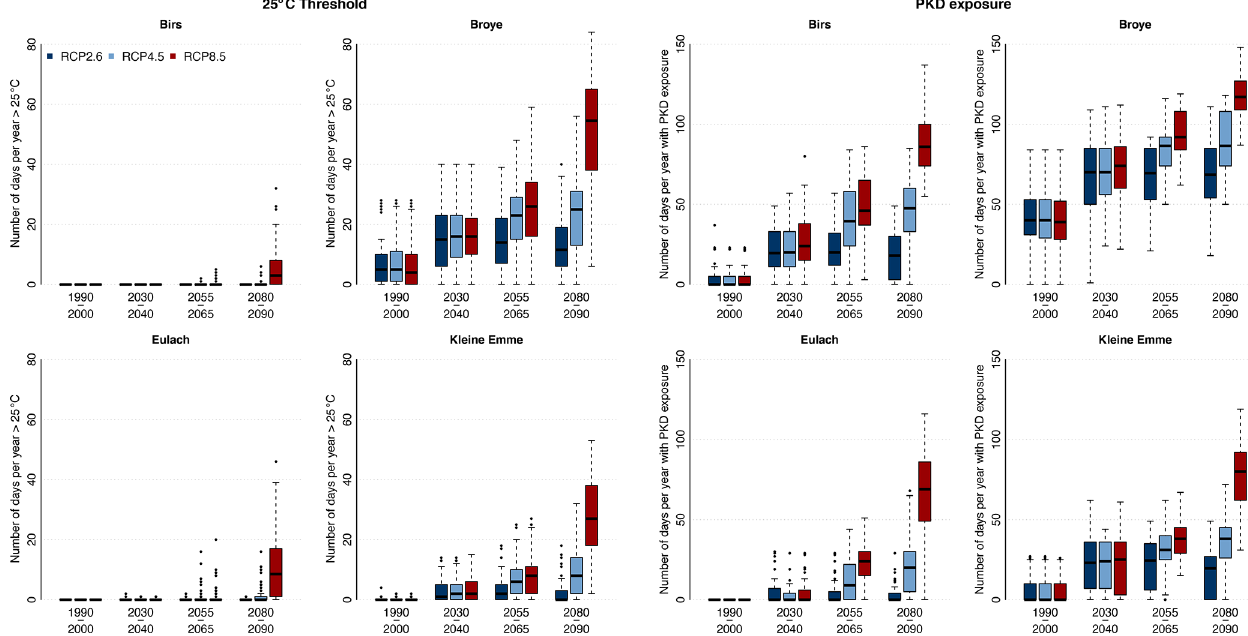
Figure 8. Left panels: number of days per year when the river temperature is above the threshold of 25 ◦ C, for each year in each time period and for each scenario, for four Swiss Plateau catchments. Right: number of days per year when salmonid populations are exposed to PKD, based on the metric presented in Michel et al. (2020), for each year in each time period and for each scenario, for four Swiss Plateau catchments. These four catchments were chosen to represent the variation in the Swiss Plateau catchment